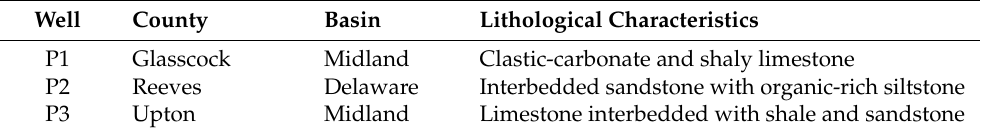
Table 1. Well location and the lithologic characteristics.